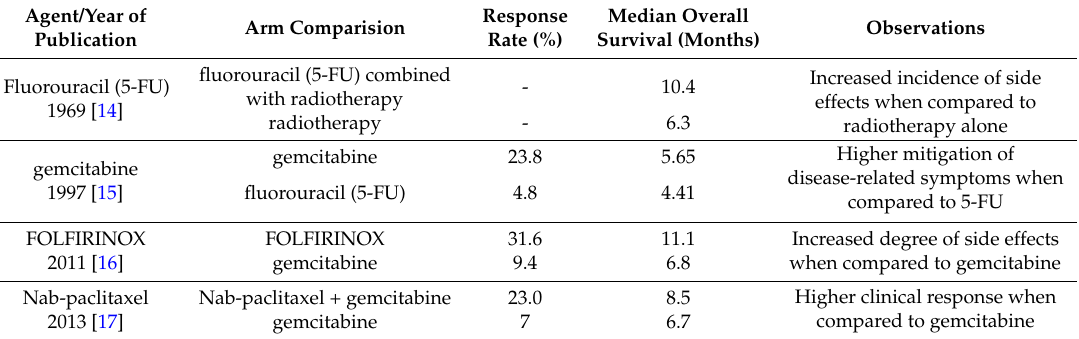
Table 1. Experimental chemotherapeutic regiments for pancreatic ductal adenocarcinoma